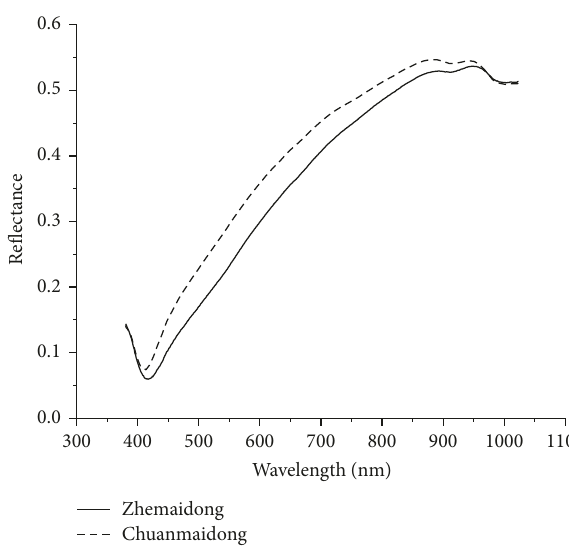
Figure 2: Average raw spectra reflectance curves of Ophiopogon japonicus .